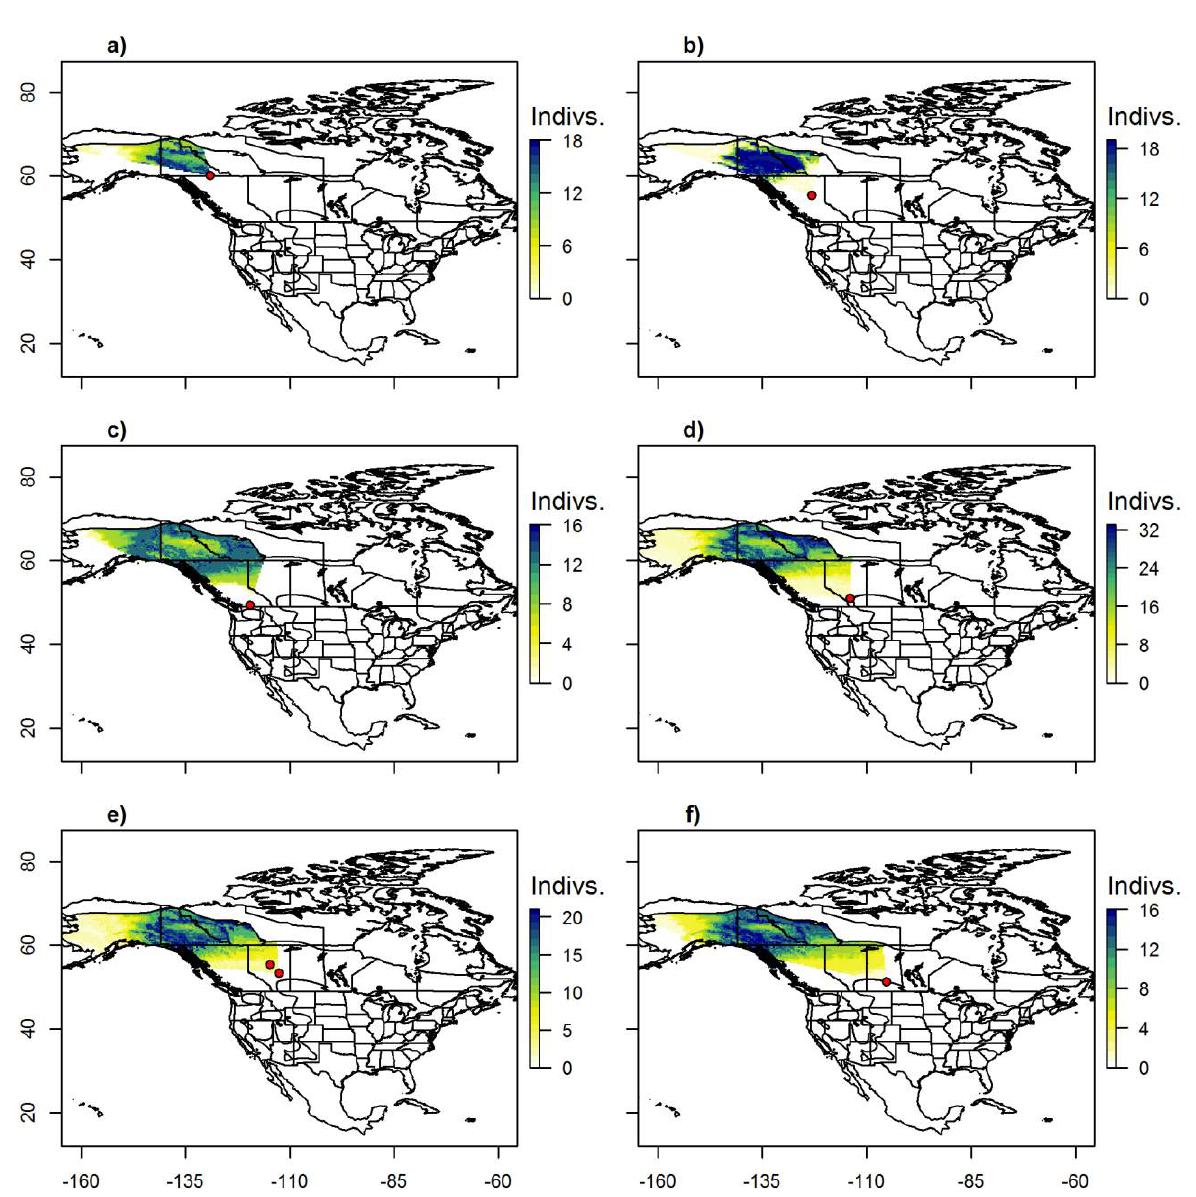
Figure A2.12: Probable origins of Orange-crowned Warblers ( Oreothlypis celata ) captured during fall migration at CMMN stations in a) the Yukon (ACBO (n=20)); b) Northern British Columbia (MNO (n=20)); c) Southern British Columbia (VLBO (n=20)); d) Southern Alberta (IBS (n=36)); e) Northern Alberta (BBO (n=12), LSLBO (n=15)); f) Saskatchewan (LMBO (n=20)); g) Manitoba (DMBO (n=16)); h) Western Ontario (TCBO (n=20)); and i) Southwest Ontario (AuBO (n=8), BPBO (n=15), HBO (n=2), LPBO (n=7), PIBO (n=2), TTPBRS